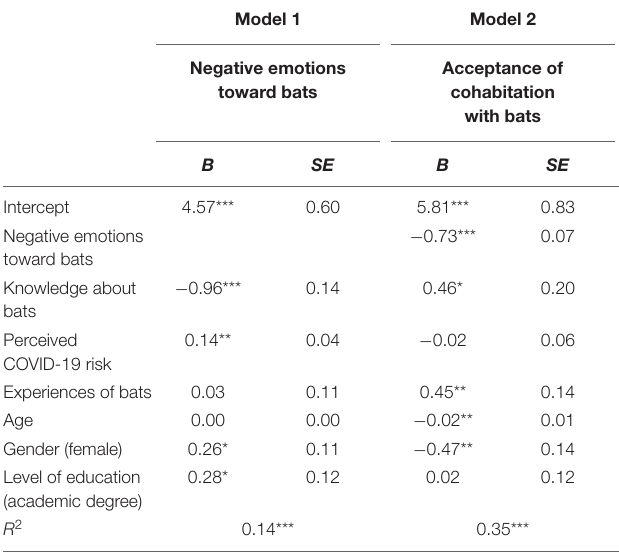
TABLE 3 | Results of the mediation model: unstandardized regression coefficients ( B ) and standard errors